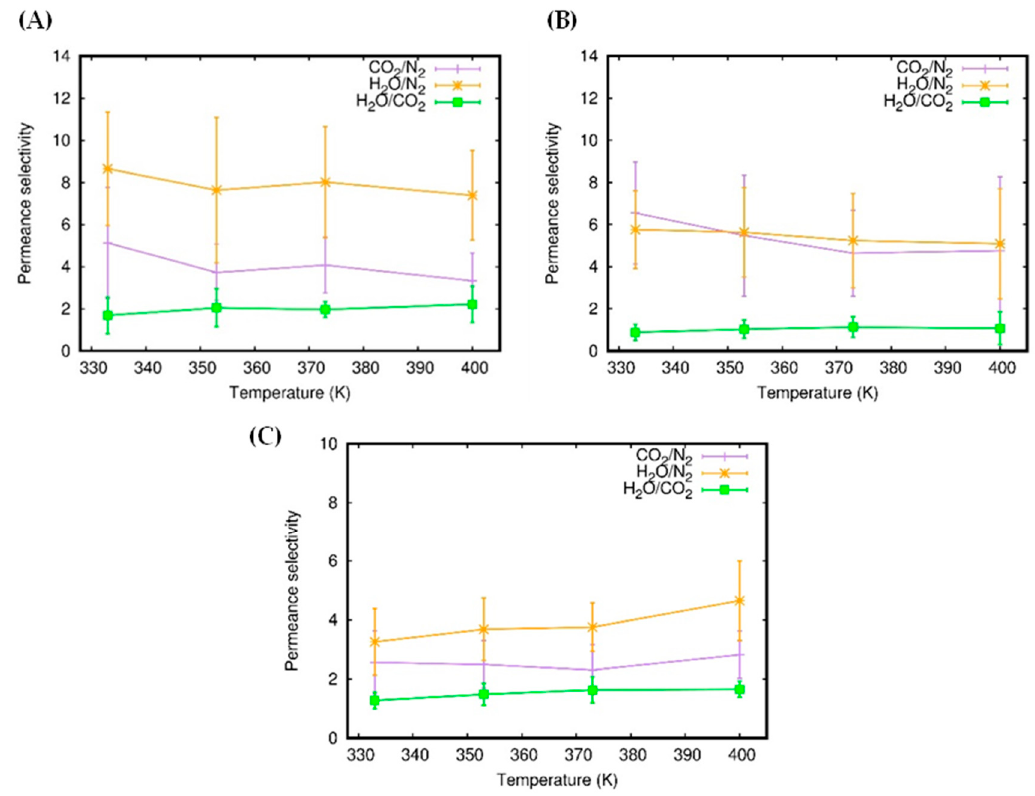
Figure 6. Permeance selectivity for single-layer ( A ), bilayer ( B ), and trilayer ( C )